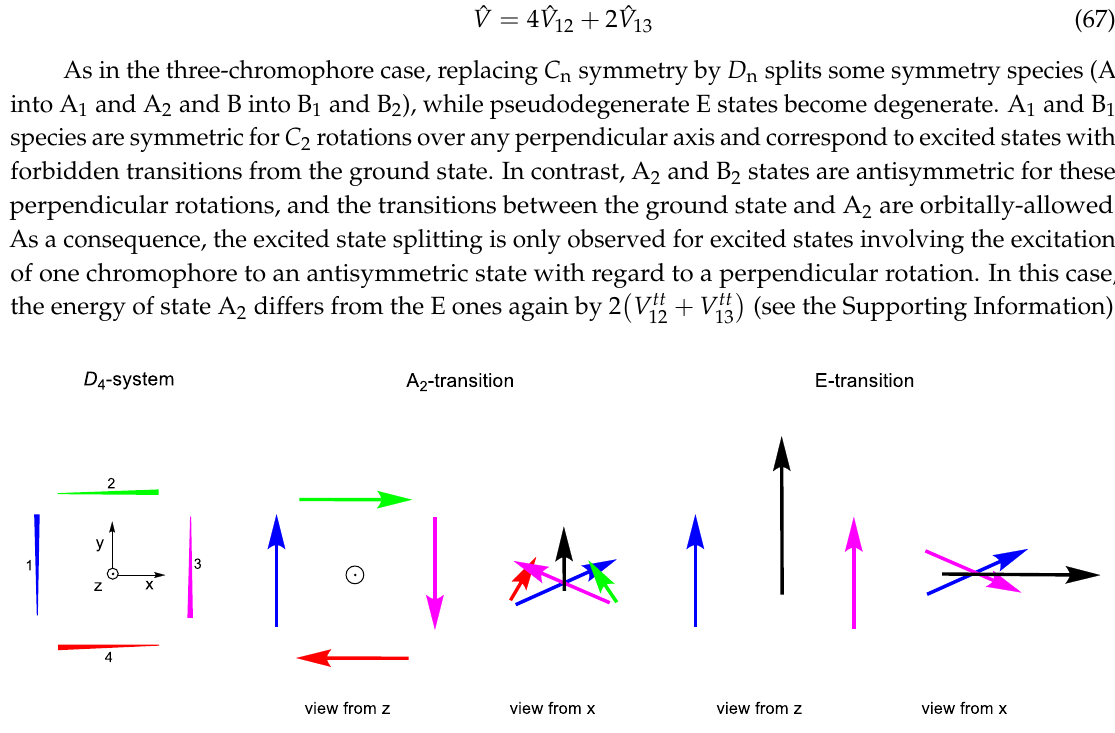
Scheme 6. Representation of a system presenting D 4 symmetry. According to the selection rules, the four equivalent chromophores 1 (blue), 2 (magenta), 3 (green), and 4 (red) can undergo a simultaneous excitation following A 2 or E symmetry leading to total EDTMs (black) parallel to z or y, respectively, as a result of the summation of the EDTM of each chromophore. A circle with a dot in the middle represents an arrow perpendicular to the plane pointing to the reader.